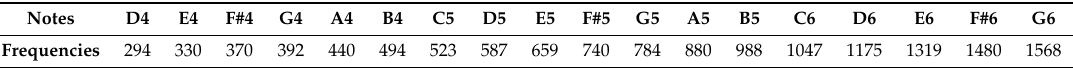
Table 1. The notes and their corresponding frequencies (rounded to the nearest integer) produced by the Pan’s